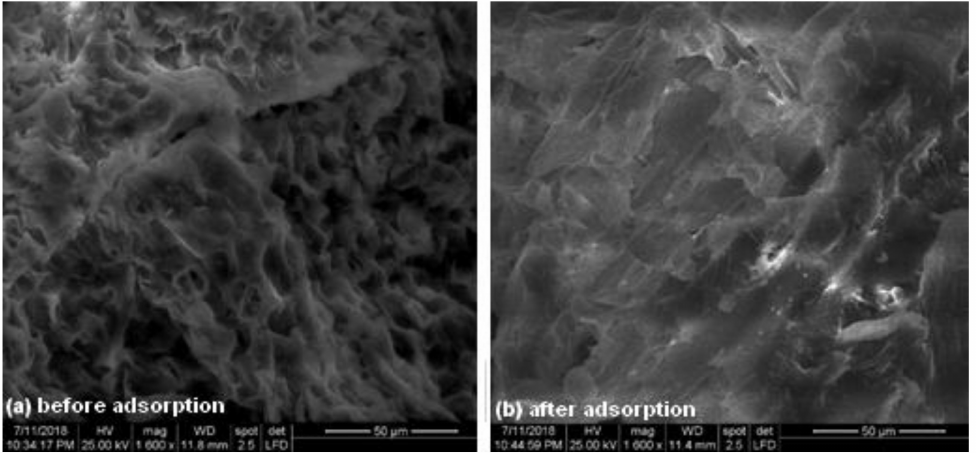
Figure 1. SEM image of adsorbent surface before ( a ) and after ( b ) crystal violet adsorption [adsorption conditions: pH 7; initial dye concentration: 100 mg · L − 1 ; contact time: 30 min; adsorbent dose: 2 g · L − 1 ; temperature: 294 K, ionic strength: 0 mol L − 1